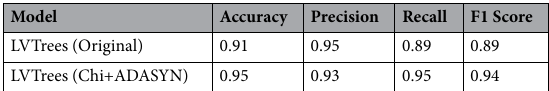
Table 16. Performance of resampling on training data alone.